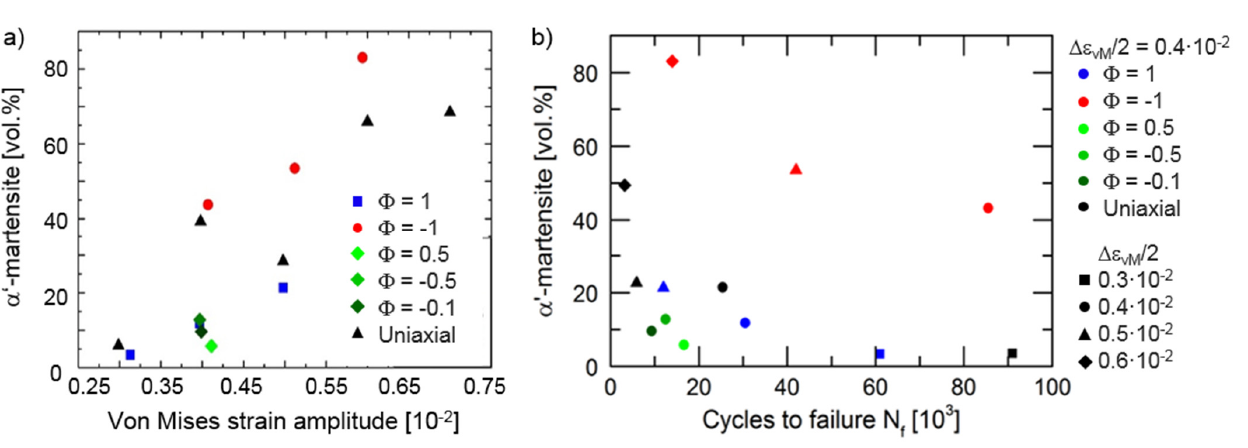
Figure 3: Correlation of  ’-martensite content of the steel PM 16-7-6 at fatigue failure vs. a) von Mises equivalent strain amplitude Δ  vM /2 and b) number of cycles to failure N f for uniaxial and biaxial tests at different strain ratios  .